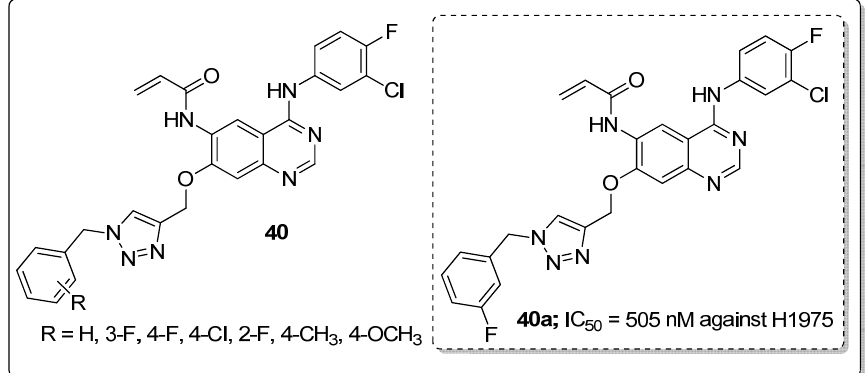
Figure 46. EGFR tyrosine kinase inhibitory activity of the most active quinazoline-1,2,3-triazole hybrids 40a .